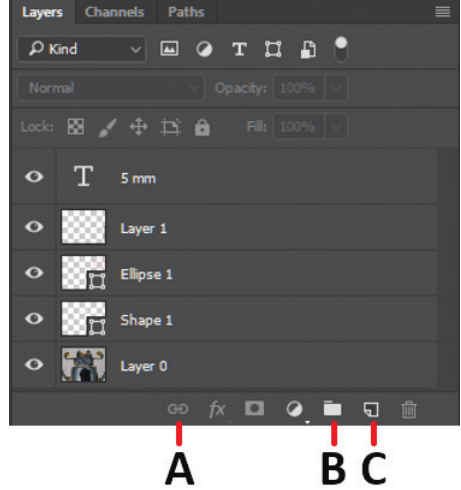
Figure 27. Layer panel. A . Icon to link layers; B . Layer group creation icon; C . Layer creation icon.